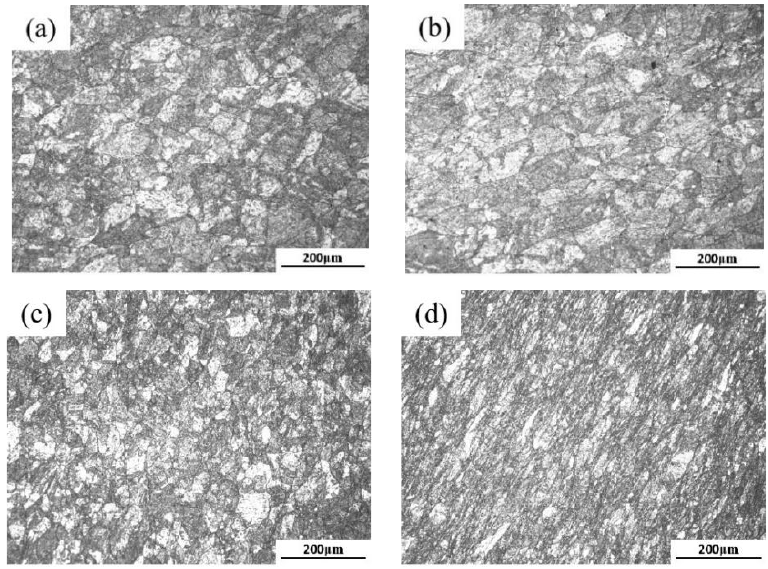
Figure 9. The metallographic photographs of C250 after heat treatment: ( a ) 15%; ( b ) 30%; ( c ) 45%; ( d ) 60%. ( d )